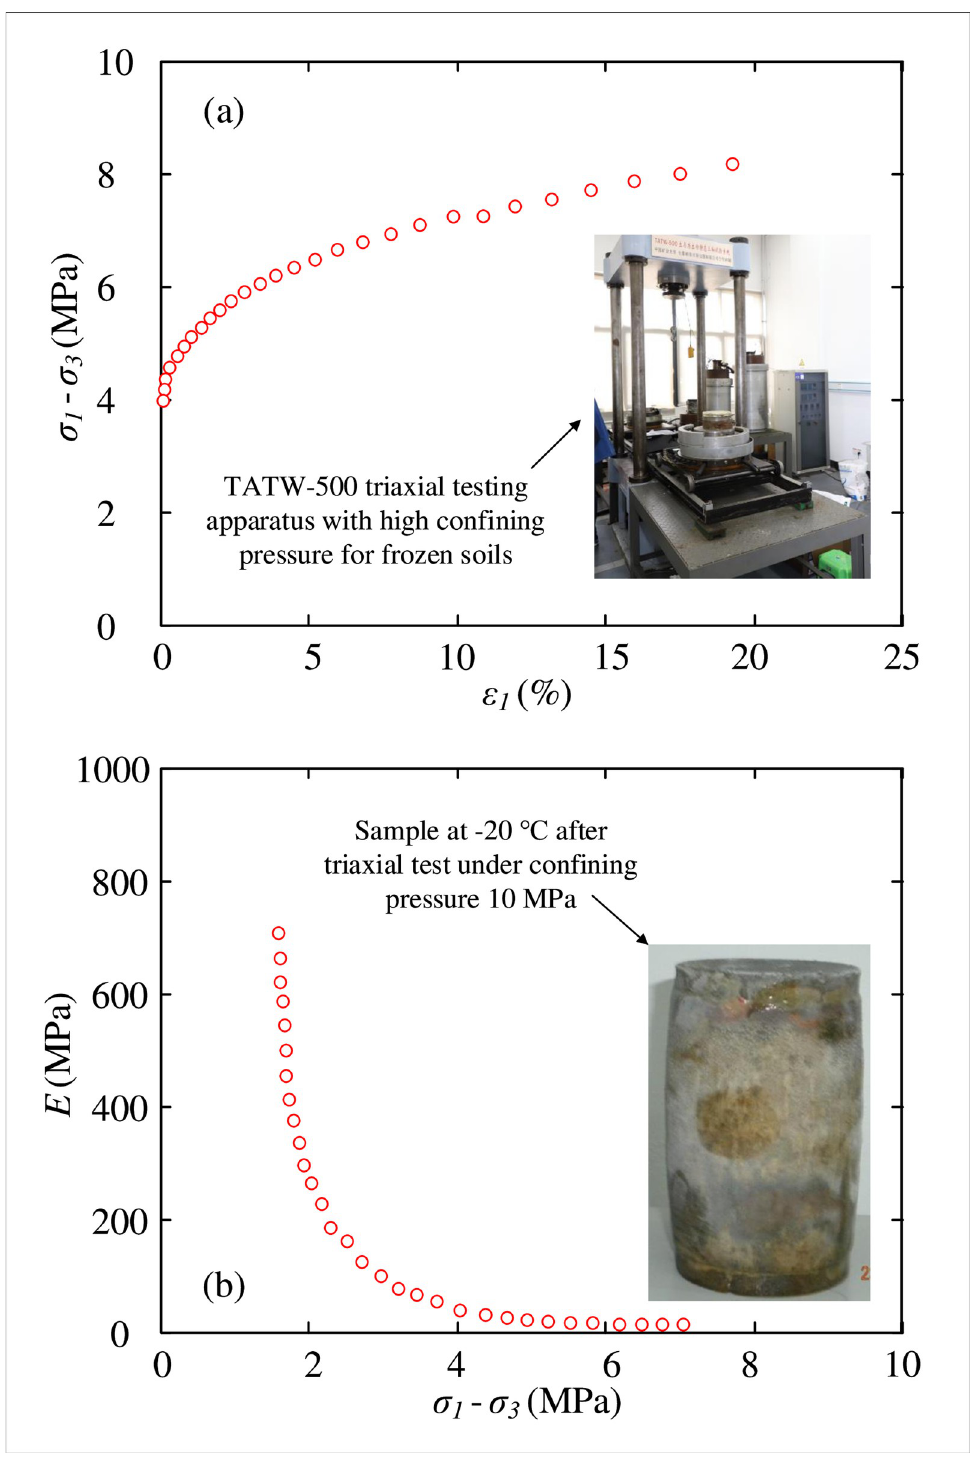
Fig 3. Typical results of a triaxial test for a sample of frozen soil at -20˚C and 10 MPa stress condition, after Leng [33].